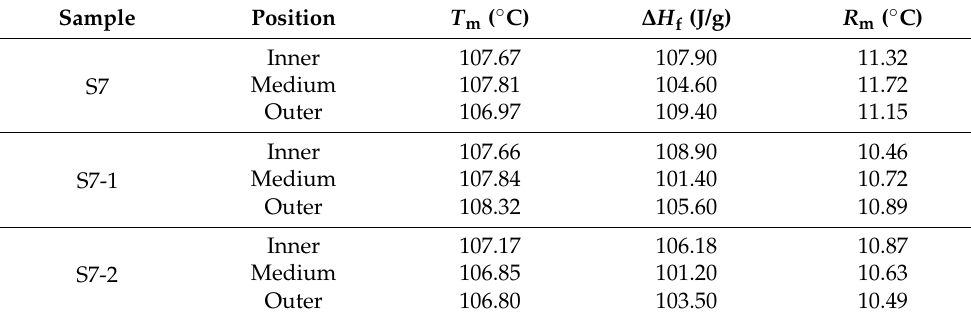
Table 2. DSC parameters of insulation layers with different aging modes.